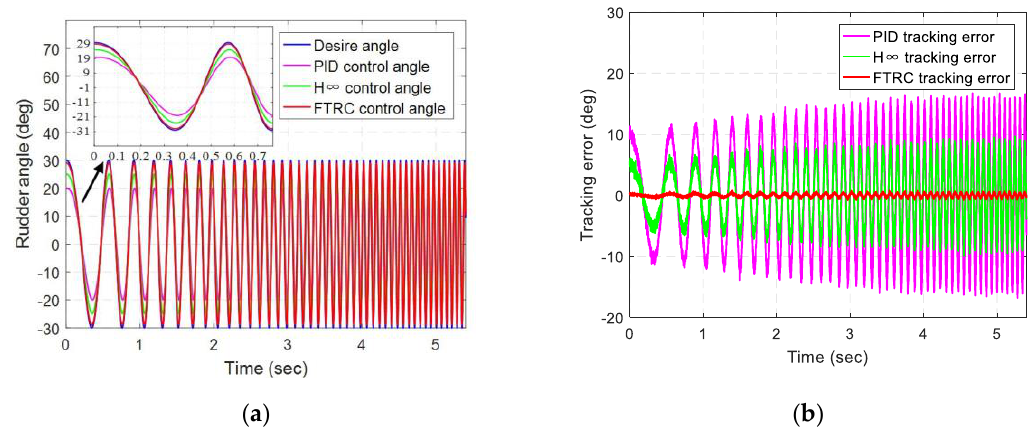
Figure 12. Actual response and error of different algorithm under input step signal: ( a ) system response; ( b ) system response error.